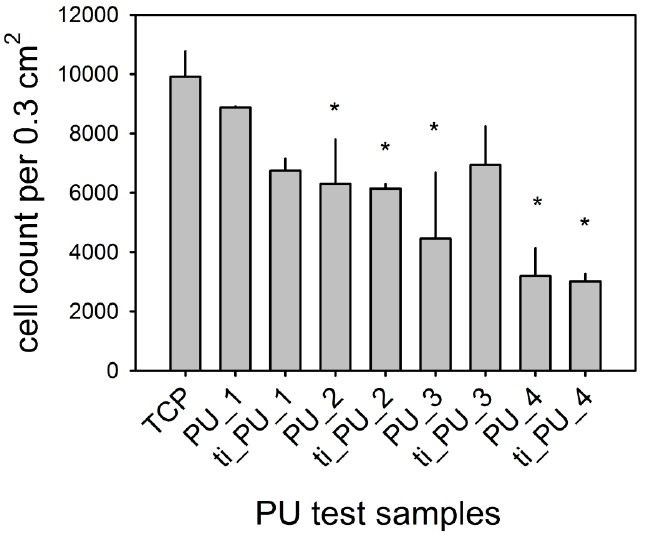
Figure 2. An in vitro study ( n = 4) over 24 hours about adhesion of human endothelial cells seeded onto different PUs. Cells were seeded (20,000 cells per 0.3 cm 2 ) onto test samples made of polyetherurethanes (PEU) (PU_1, PU_2, PU_3) and polycarbonateurethanes (PCU) (PU_4) without and with titaniferous upgrading (ti_PU) and tissue-cultured polystyrole (TCP) for 24 hours. Data are presented as mean with standard deviation. Statistical analysis included comparison of test materials with TCP (*, p ≤ 0.05).